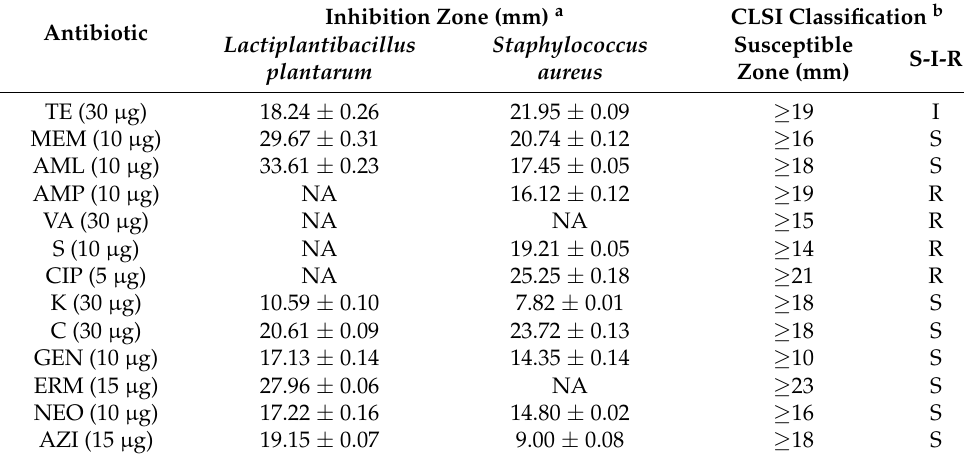
Table 2. Strains antibiotic susceptibility test.